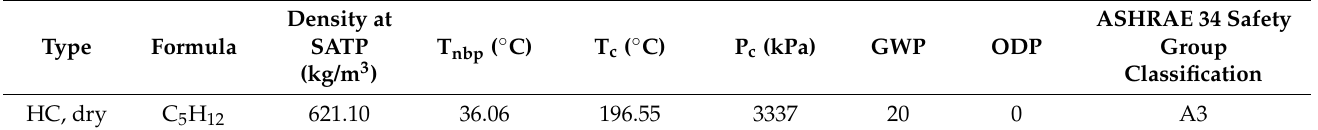
Table 2. Main properties of the n -pentane (R601) working fluid [43]. Density Type Formula